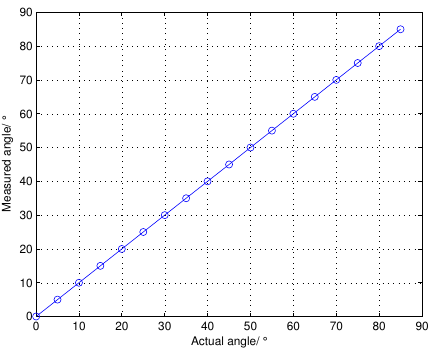
Figure 7. The performances of the cross-correlation angle estimation (CCAE) in different target angles.